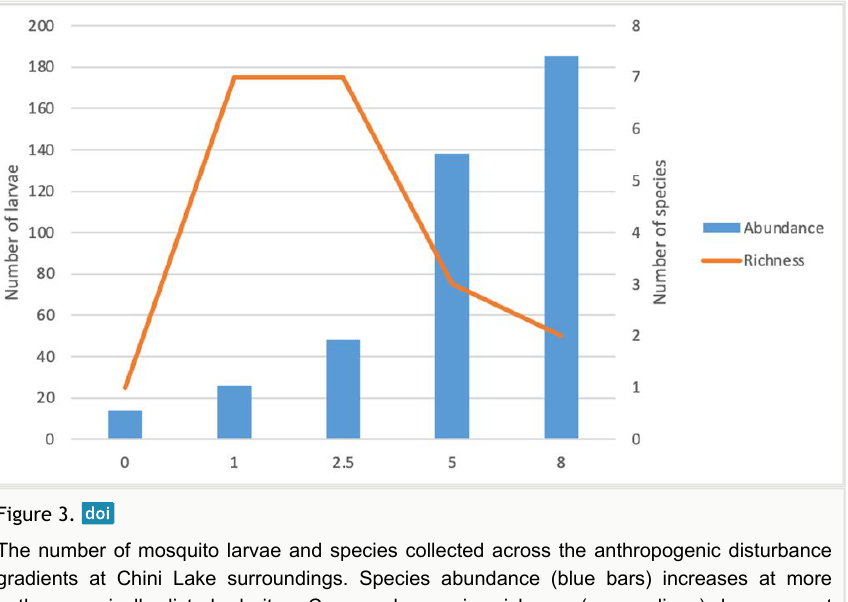
The number of mosquito larvae and species collected across the anthropogenic disturbance gradients at Chini Lake surroundings. Species abundance (blue bars) increases at more anthropogenically disturbed sites. Conversely, species richness (orange lines) decreases at the more anthropogenically disturbed sites. Based on the Bray-Curtis dissimilarity measures, sites with high to moderate disturbance scores (2.5-8.0) were grouped in the NMDS plot. However, the two lowest disturbance score sites, swamp forest (disturbance score = 0.0) and floating island (disturbance score = 1.0) showed distinctively different mosquito community compositions (Fig. 4).